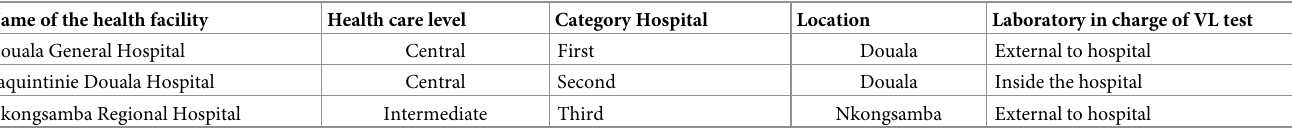
Table 1. Characteristics of the selected health